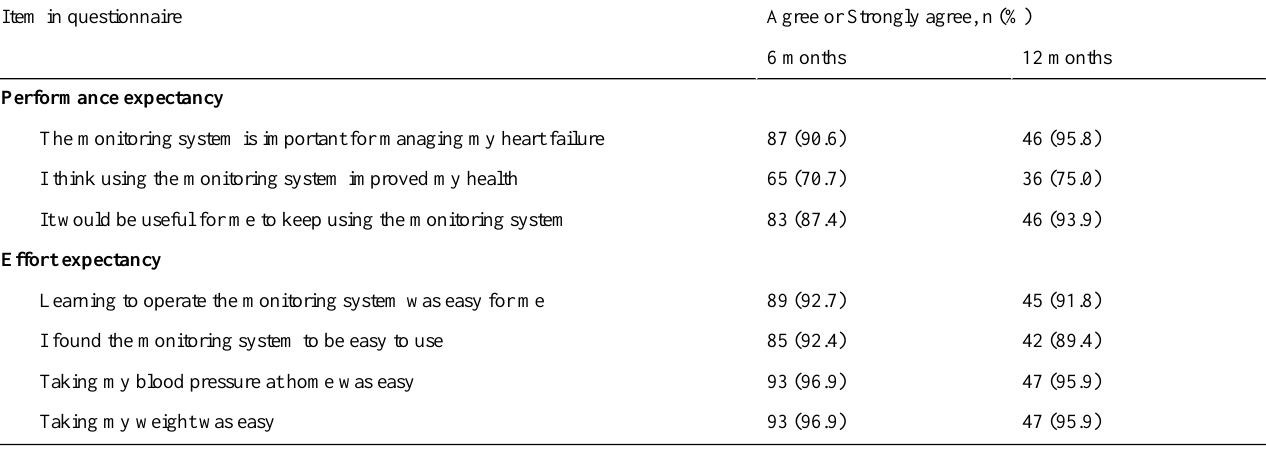
Table 3. Patient perceptions of the benefits and effort of using the Medly TM system at 6 and 12 months postenrollment.